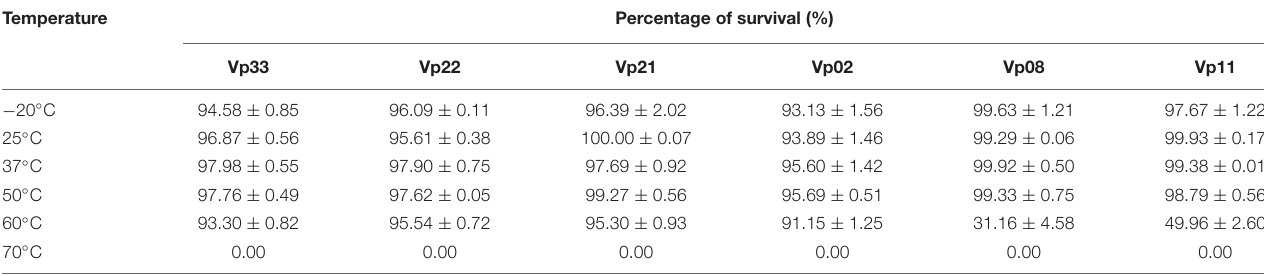
TABLE 4 | Temperature stability of bacteriophages. Temperature